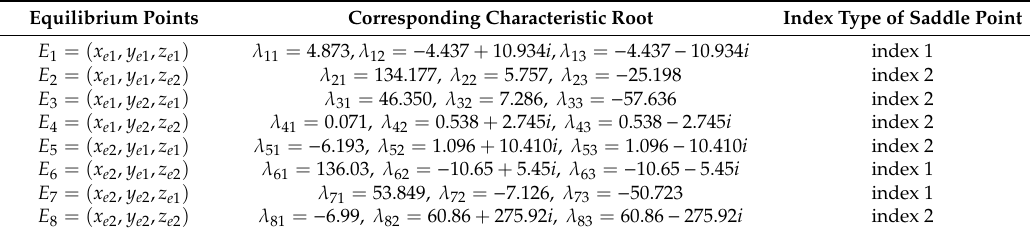
Table 1. The equilibrium point types of system